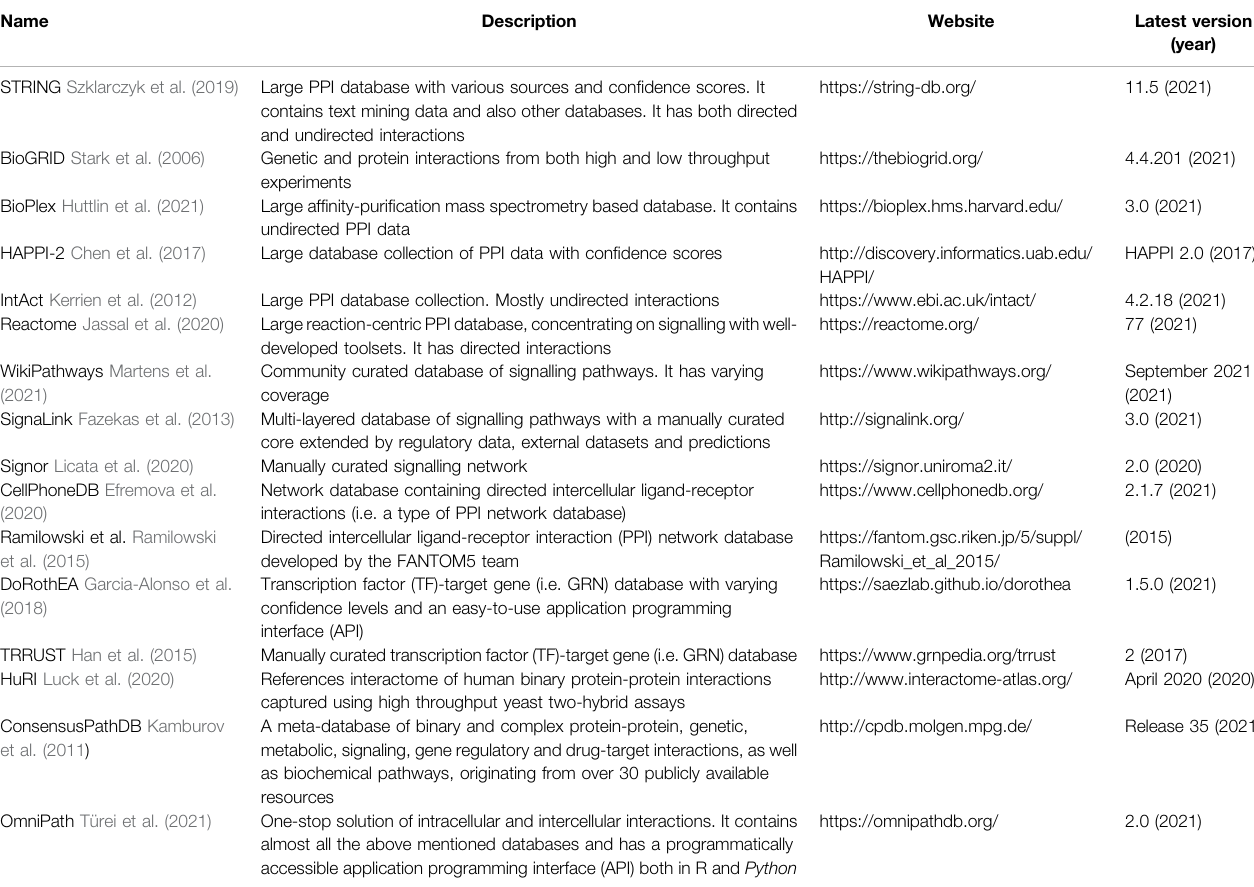
TABLE 2 | Network resources relevant to IBD